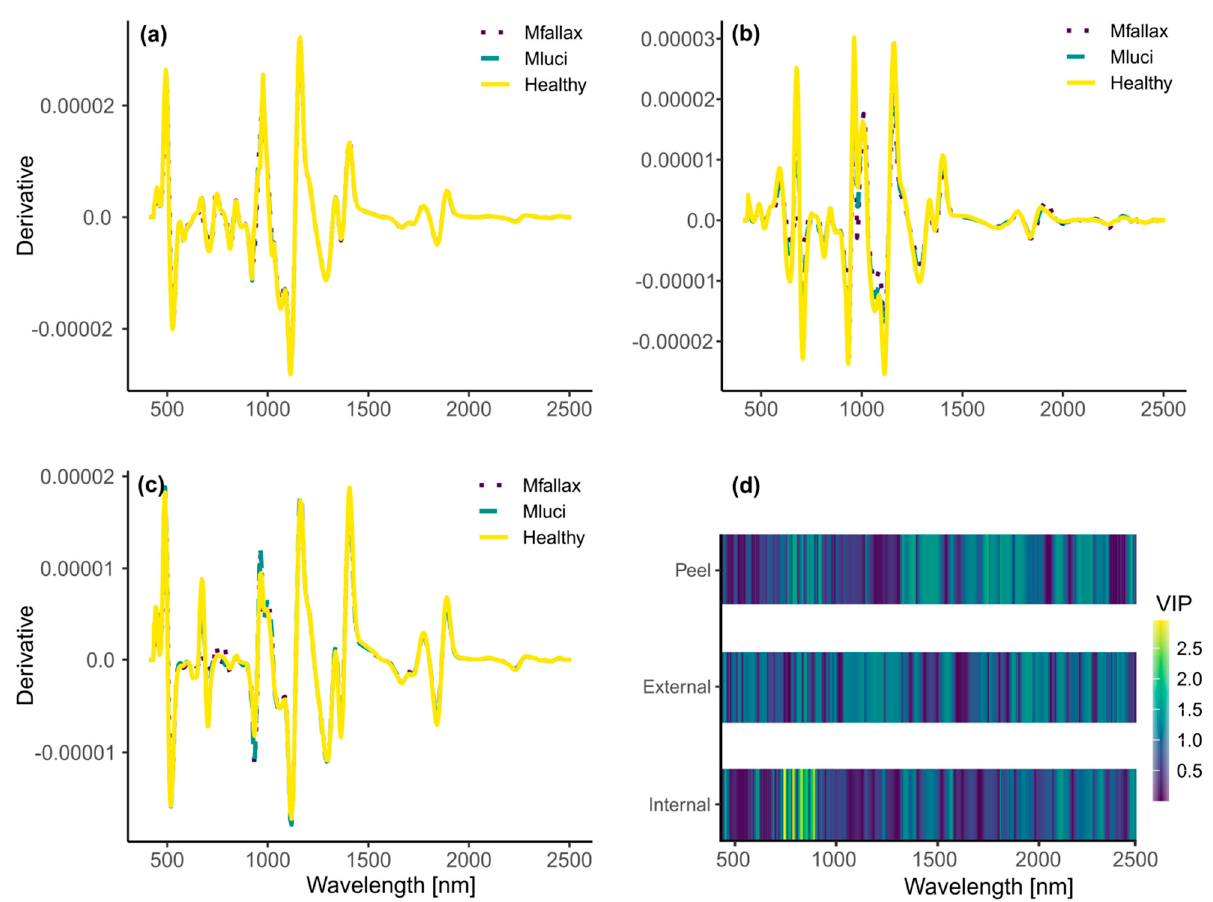
Figure 8. Spectral derivatives ( a – c ) and VIP results ( d ) of Meloidogyne luci and M. fallax data: ( a ) internal data, ( b ) peels, ( c ) external data, ( d ) VIP scores—wavelengths above 1 were considered as relevant for identifying nematode species.